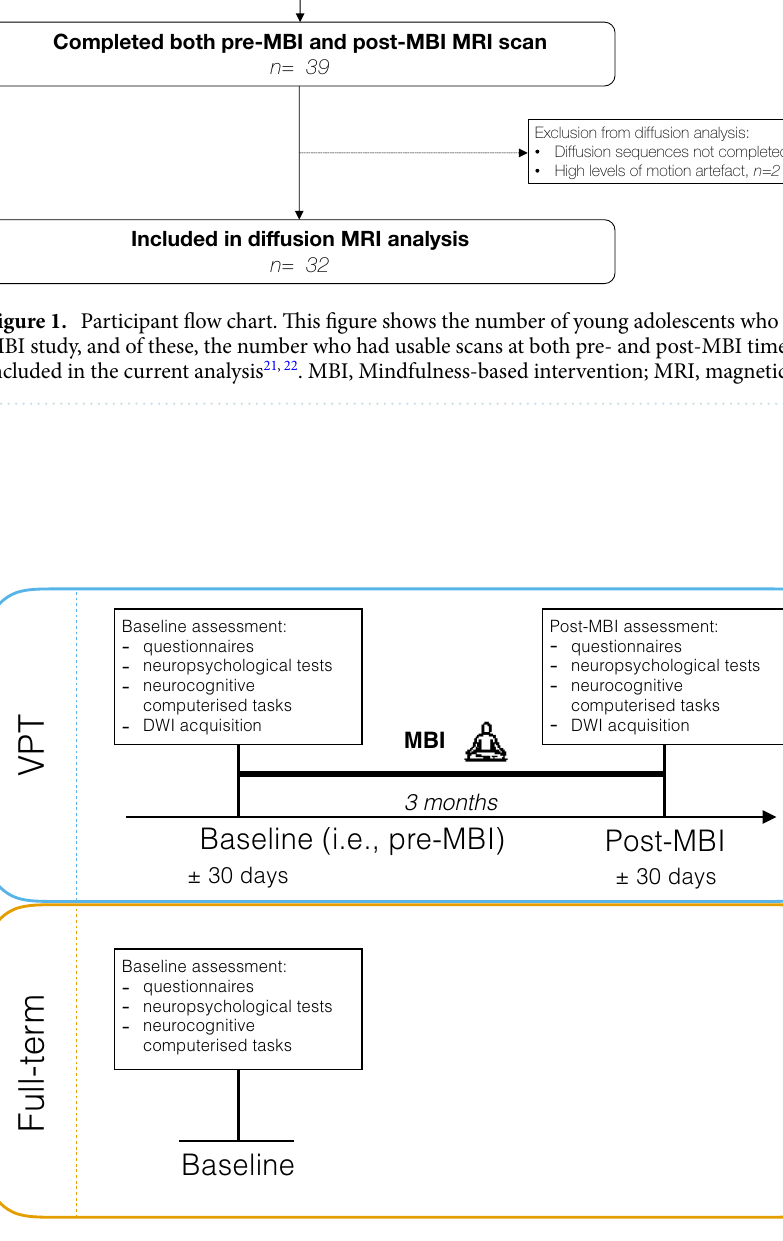
Figure 2. Illustration of the pre-post intervention design of the current study 22 . The VPT group is represented in blue and the full-term control group is represented in